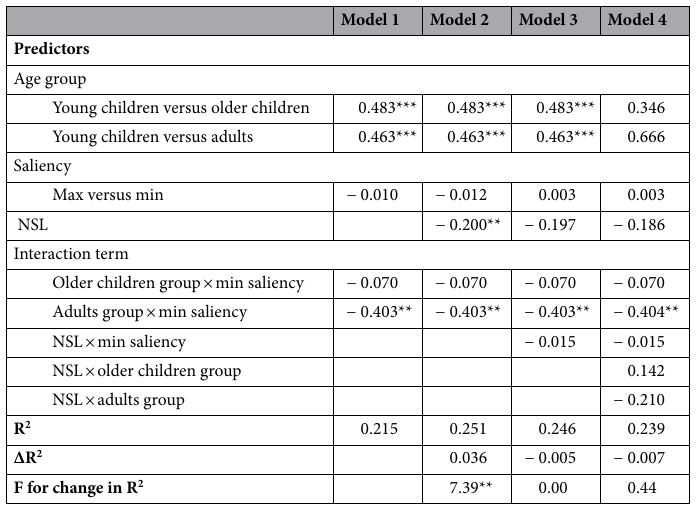
Table 4. Summary of the hierarchical regression analyses for variables predicting ‘Sure’ responses. Standardized regression coefficients (β) are reported for each predictor. The age group was presented as three dummy variables (young children, older children, and adults) with young children serving as reference group. The saliency condition was presented as two dummy variables (Max and Min) with Max saliency serving as reference condition. * p < .05, ** p < .01, *** p < .001.